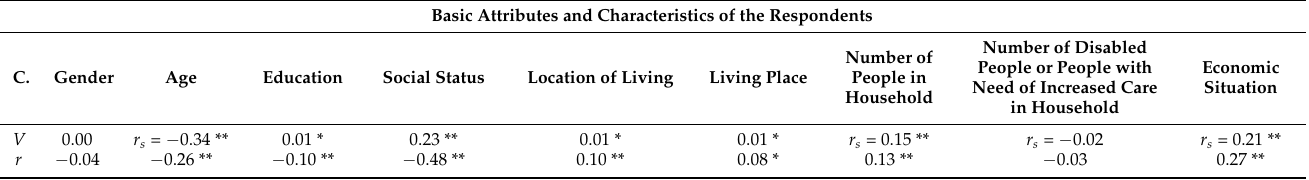
Table 4. Association and correlation between the dependent variable and basic attributes and characteristics of the